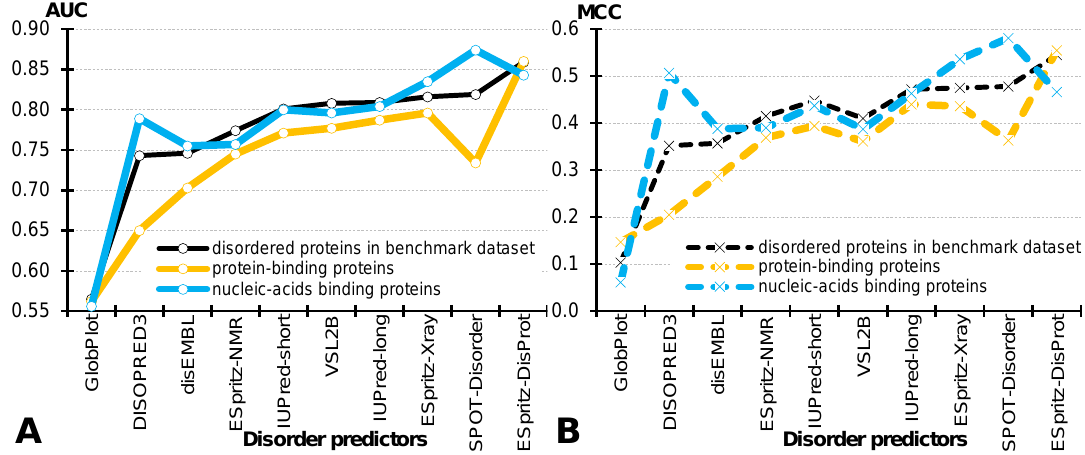
Figure 3. Comparison of the predictive quality measured with AUC (panel A ; solid lines) and MCC (panel B ; dashed lines). We report results on the generic set of disordered proteins (i.e., proteins that have disordered residues) from benchmark dataset (in black), the disordered protein-binding proteins (in orange), and the disordered nucleic-acid-binding proteins (in blue). Disorder predictors are sorted by their AUC values on the disordered proteins.